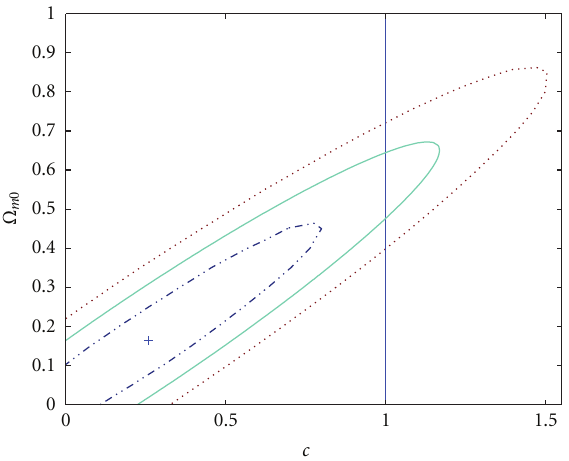
Figure 5: Parameter constraints for the holographic dark energy model in the Ω m - c plane, by Yi and Zhang [81]. The constraints were obtained using age-determined H ( z ) data in [28] alone. The cross in the lower-left marks the best-fit value. The dash-dotted, solid, and dotted contours mark the 68 . 3%, 95 . 4%, and 99 . 7% confidence regions, respectively. Although some degeneracy exists, it is evident that the data favor models with c <